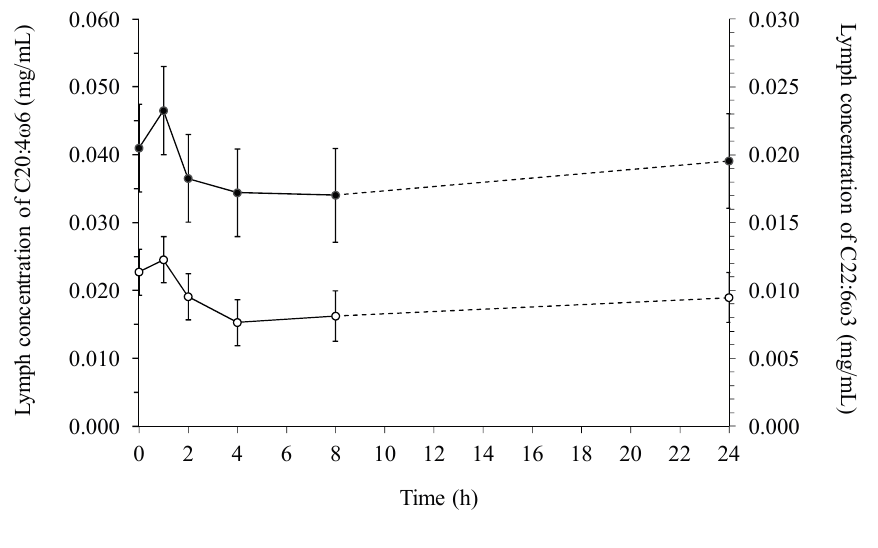
Figure 3. The average lymphatic concentration (mg/mL) of arachidonic (C20:4 ω 6, ● left) and docosahexaenoic (C22:6 ω 3, ○ right) acid across diets over time.